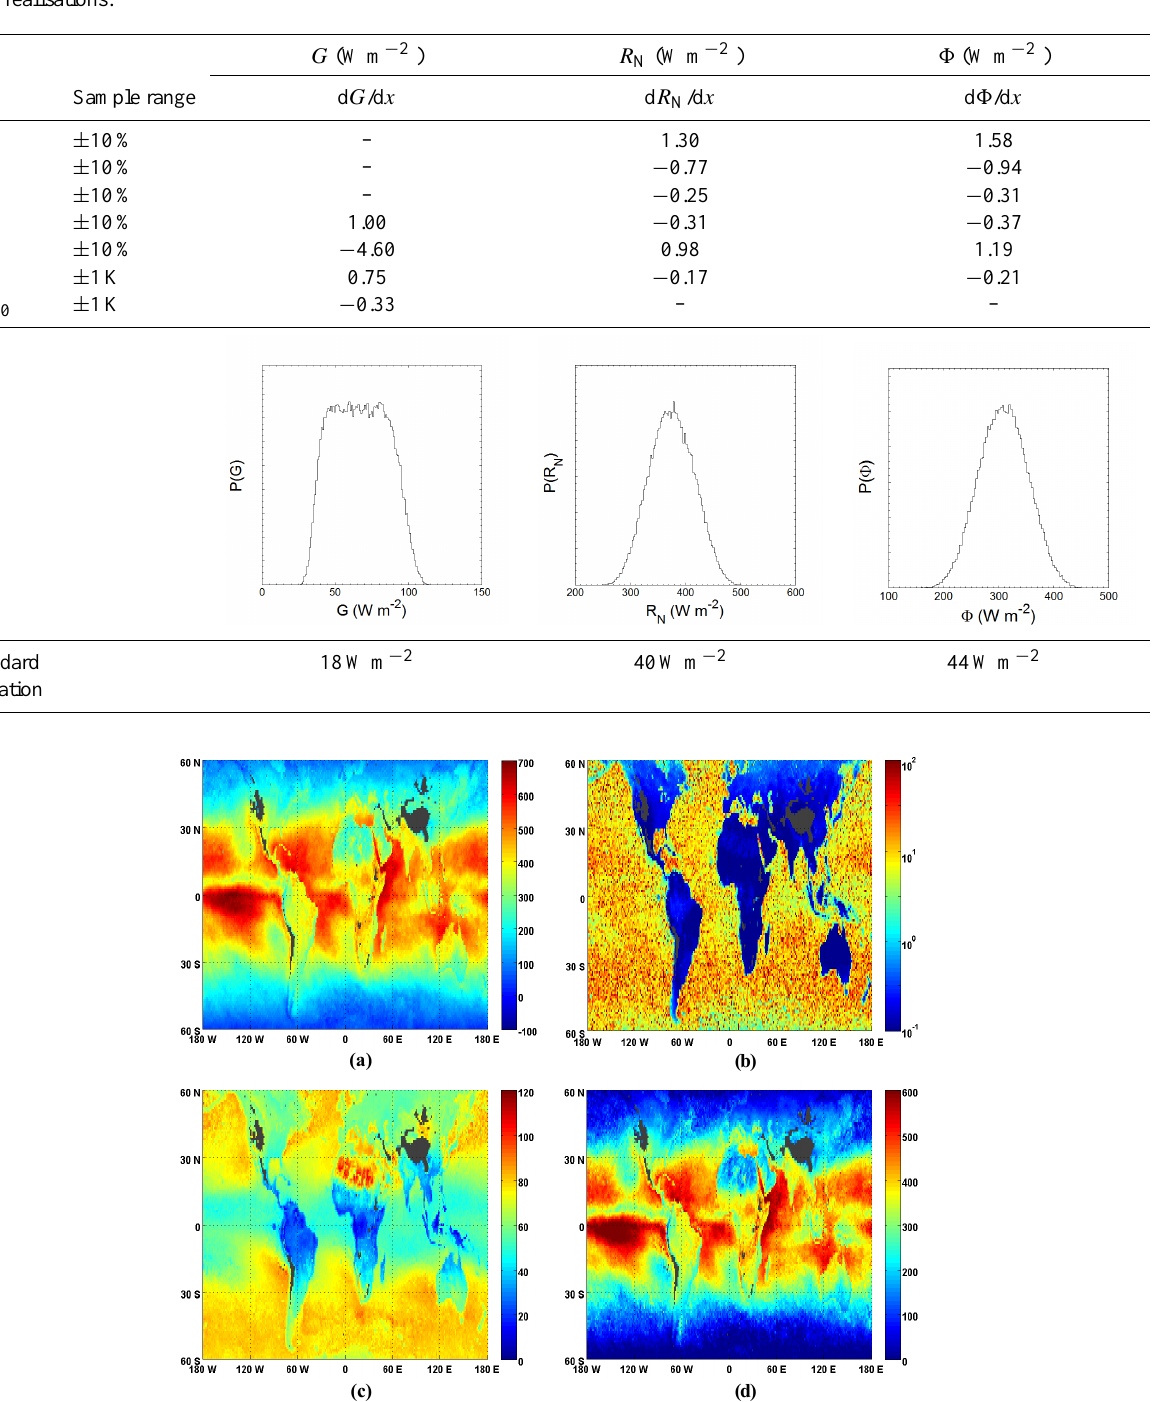
Table 2. Sensitivity analysis results. The forcing data are taken for midsummer in the Southern Great Plains, USA. Sensitivities are locally linear, averaged across the ensemble response and expressed as dimensionless relative changes. Only absolute sensitivities >0.1 are shown. N = 10 5 realisations.